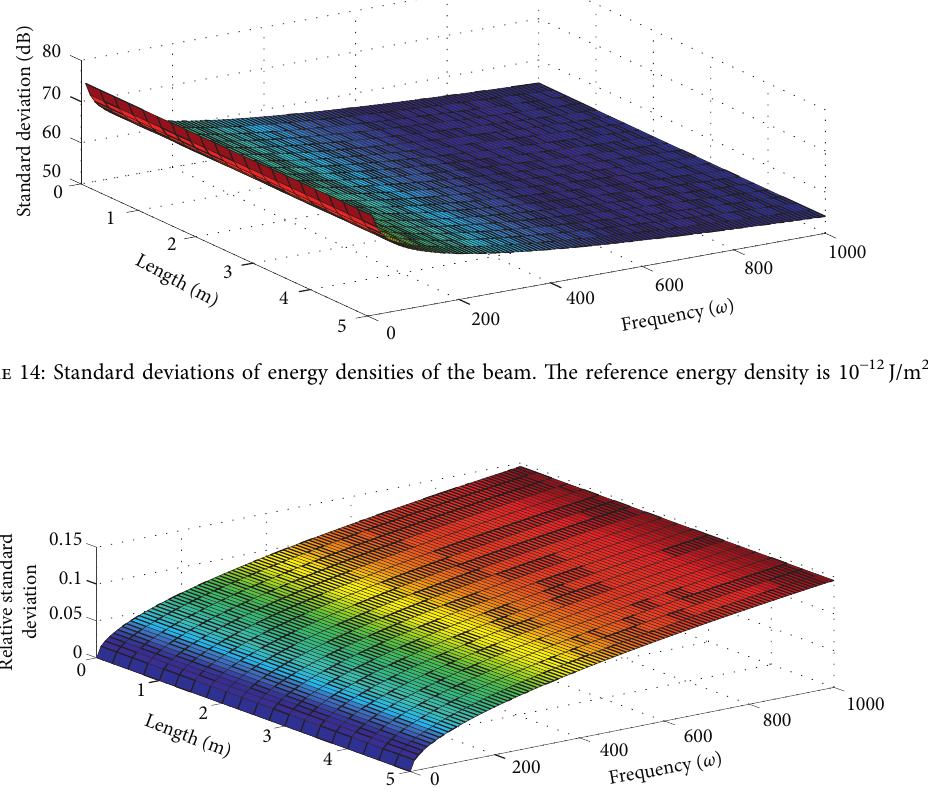
Figure 15: Relative standard deviations of energy densities of the